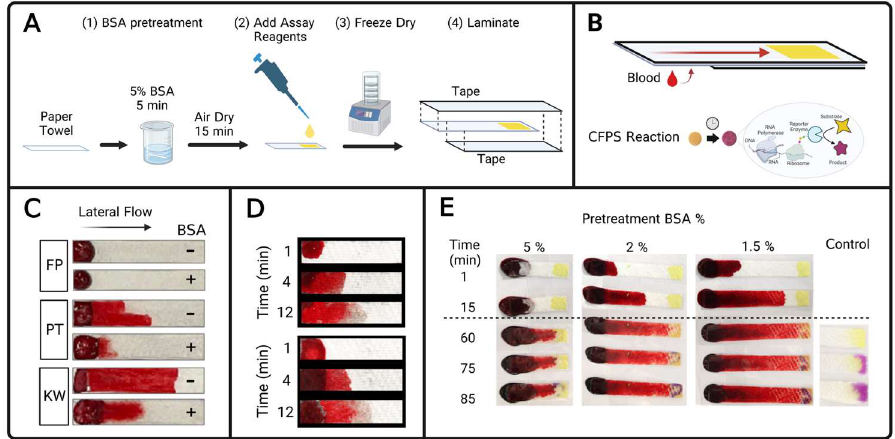
Figure 1. Low-cost serum extraction from blood for cell-free protein synthesis (CFPS) colorimetric reactions. ( A ) Assembly workflow of a prototype filtration test. Paper is first soaked in a 5% BSA solution and allowed to air dry. Assay reagents are pipetted onto the papers which are then air dried or freeze dried. Papers are then laminated with tape on both sides, except for a sample entry area which is not taped. ( B ) Assembled diagnostic in which human blood is applied to the underside sample entry area and capillary action induces lateral flow of the sample to the reagents. Hydration initiates a colorimetric CFPS reaction which produces an enzyme, β-galactosidase, which converts the yellow substrate chlorophenol red β-D galactopyranoside (CRPG) into a purple product. ( C ) The blood filtration capability of different materials with (+) and without (−) BSA blocking. FP is filter paper, PT is paper towel, KW is Kim wipe. Photographs were obtained after 15 min of lateral flow filtration had occurred. ( D ) Two replicates of a BSA blocked and tape-laminated paper towel in a blood filtration time course, with photographs from duplicate experiments shown after 1, 4 and 12 min. ( E ) Photographs of generic colorimetric CFPS reactions hydrated with serum that is passively extracted from blood via filtration by a BSA-blocked paper towel. 60 µL of fresh blood was promptly pipetted onto a flat surface and a pre-made filtration lateral strip was placed so that the exposed area of the paper was placed on top of the blood drop. Each column of photographs